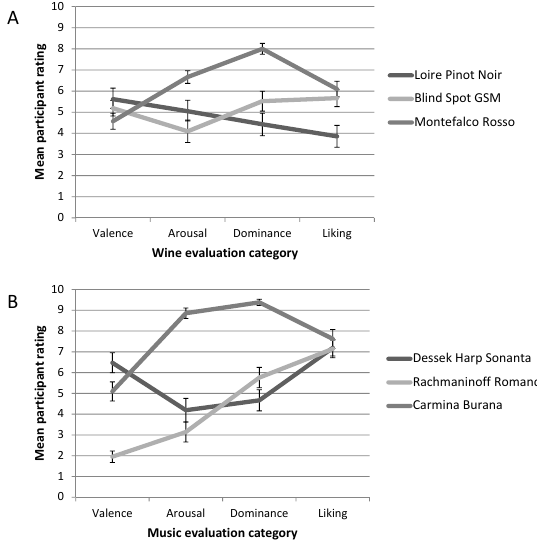
Figure 2. Mean emotion ratings of the wines ( A ) and music ( B ), each on a scale of 0–10, for valence (0 = sad, 10 = happy), arousal (0 = calm, 10 = exciting), and dominance (0 = weak, 10 = powerful). Liking for the wine or music was also evaluated (0 = hate it, 10 = love it). The error bars represent the standard error of the